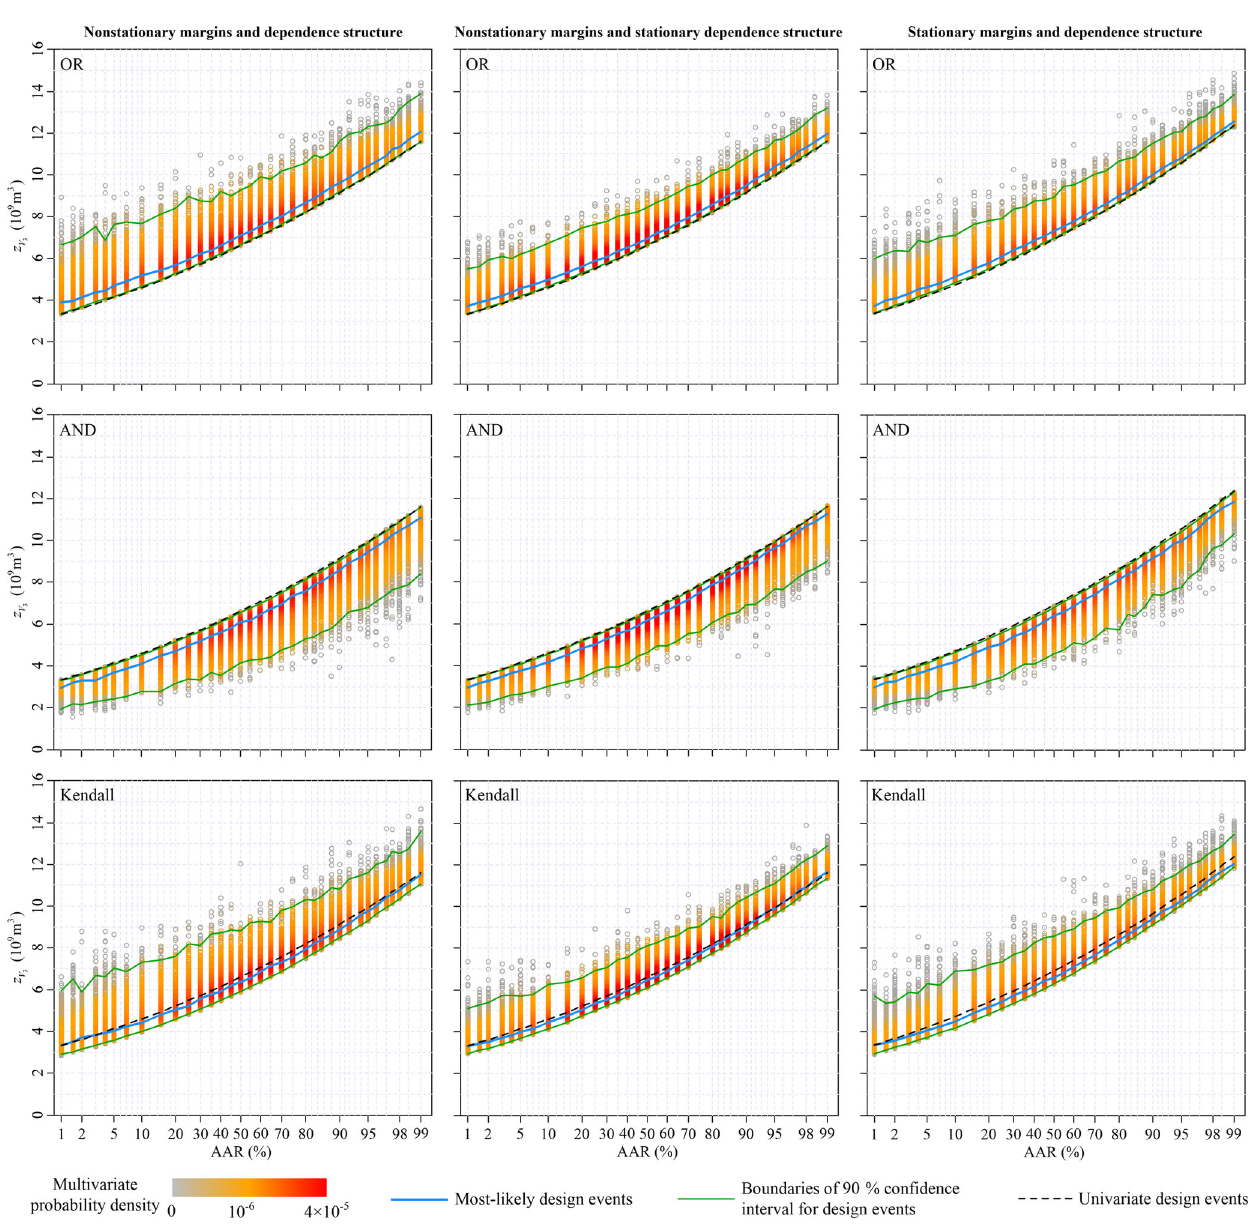
Figure 8. Design values of the 3-day flood volume for different average annual reliability (AAR) varying from 0.01 to 0.99 under three nonstationary